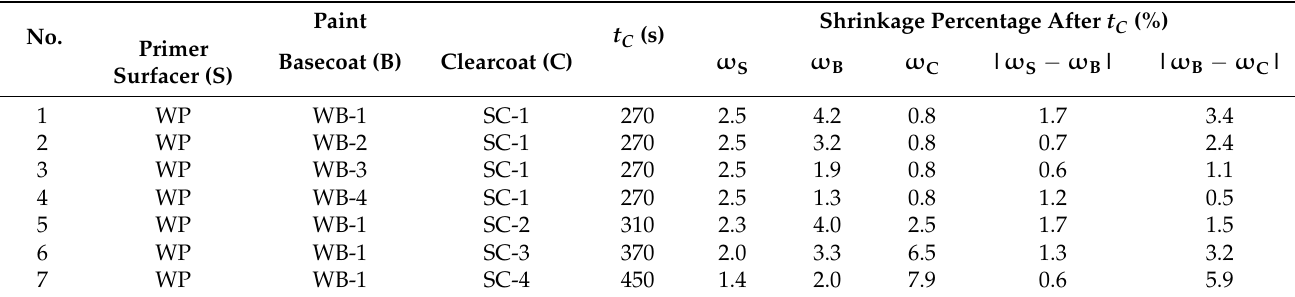
Table 6. Paint combinations and shrinkage percentages after t C .